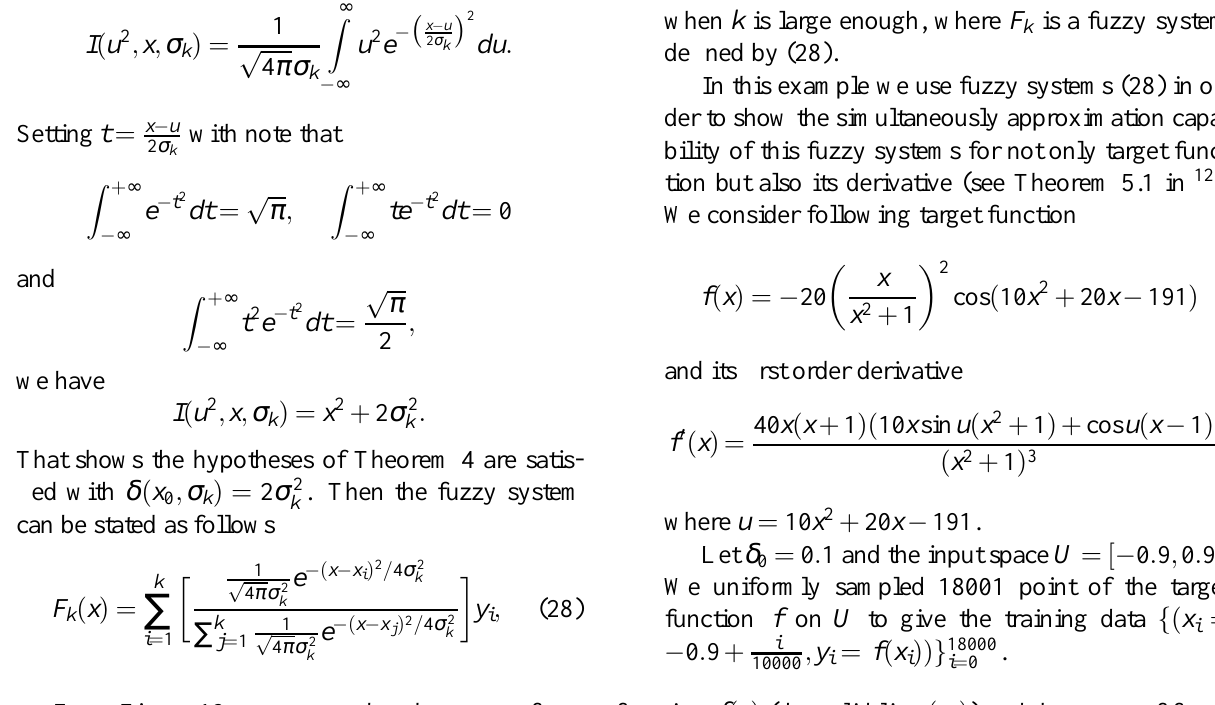
) ) and the curve of fuzzy −